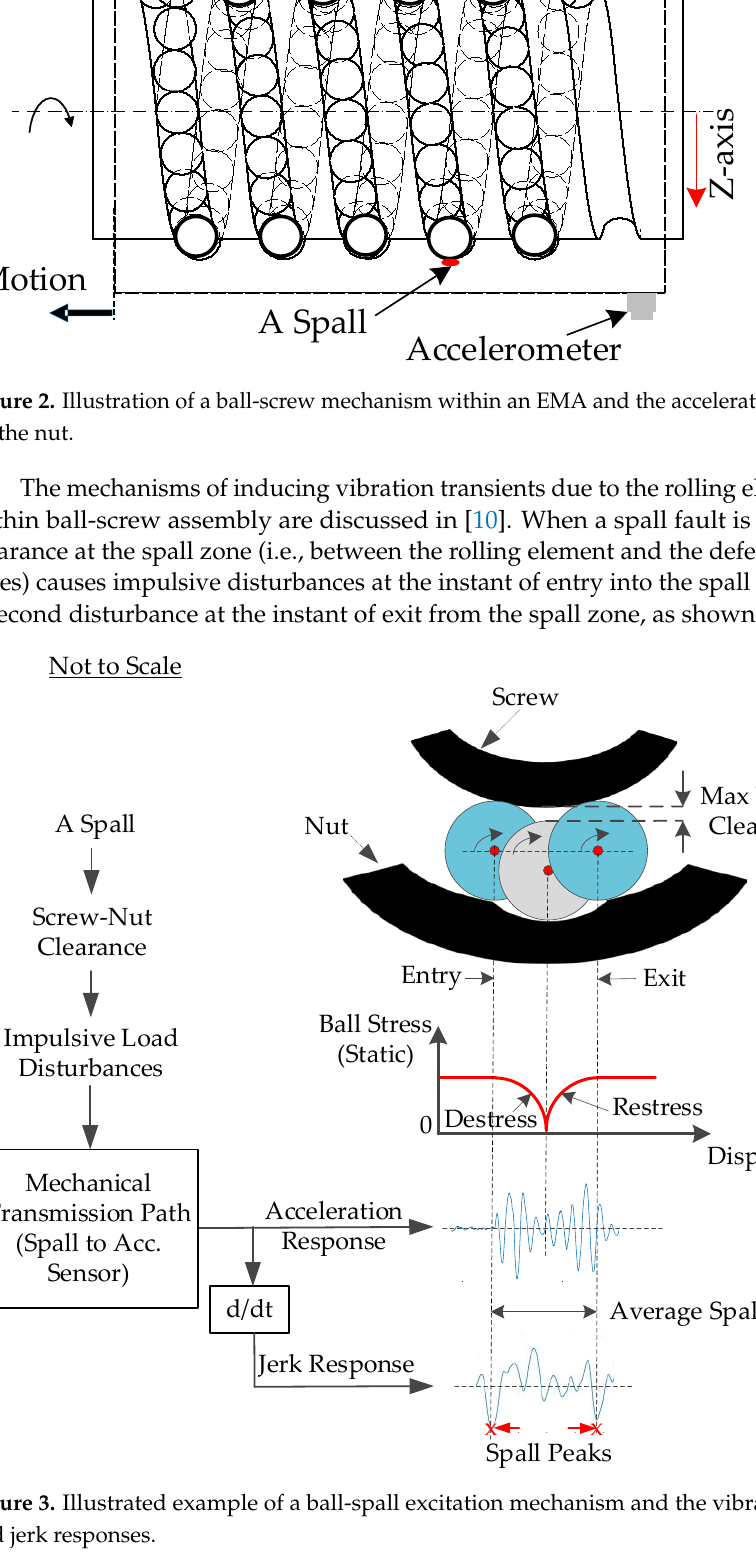
Figure 3. Illustrated example of a ball-spall excitation mechanism and the vibrational acceleration and jerk responses.